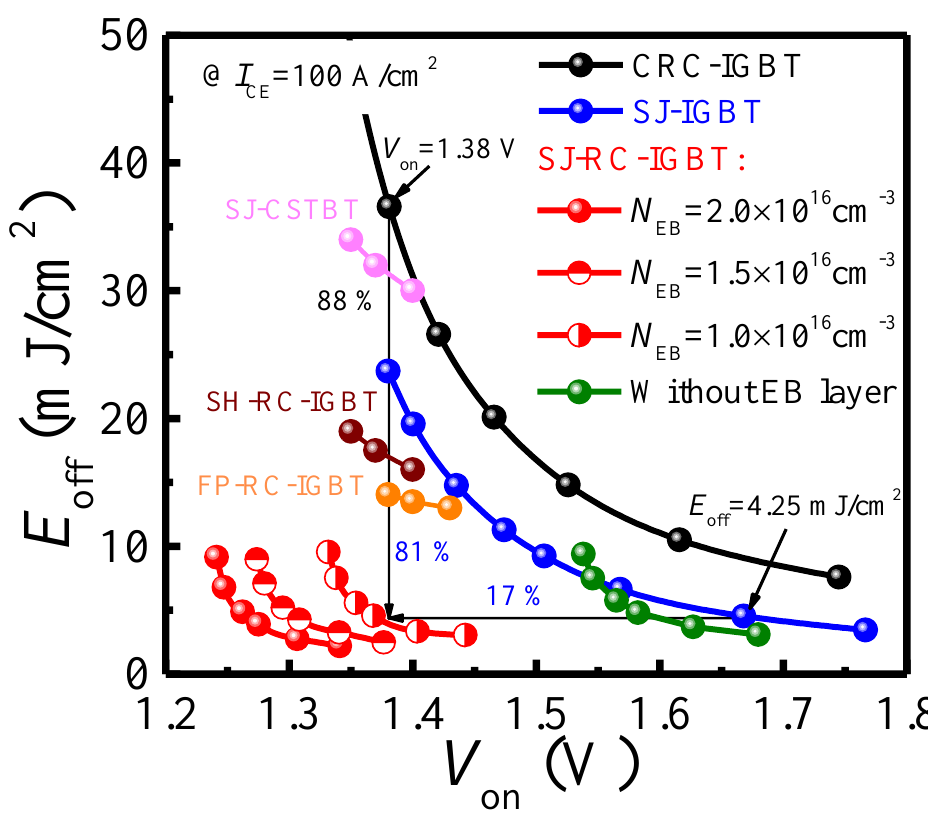
Figure 9. E off -V on relationship of SJ-RC-IGBT, SJ-IGBT, and CRC-IGBT. E off -V on relationship at I CE = 100 A/cm 2 . FP-RC-IGBT is referenced from [8]. SH-RC-IGBT is referenced from [11]. SJ-CSTBT is referenced from [22].